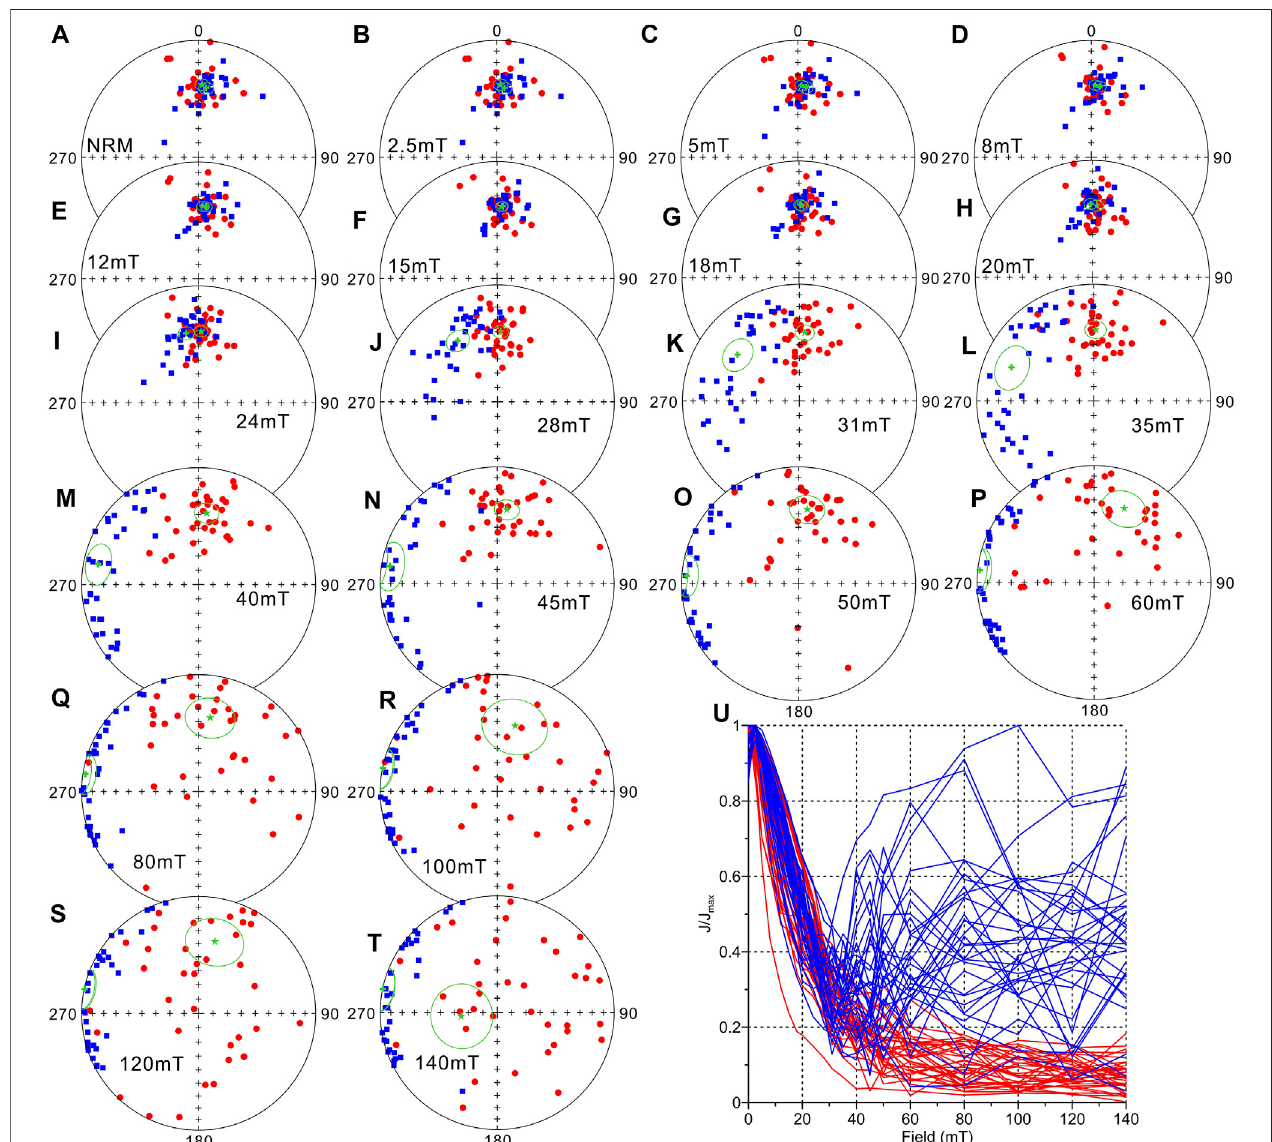
FIGURE8|(A – T) Equal-areaprojectionsoftheAFdemagnetizationdirectionsateach step.Reddots(bluesquares)denotethesamplesofType1and2samples. All diagrams are displayed in geographic coordinates. (U) Normalized remanence decay curves. Red (blue) lines denote the samples of Type 1 (Type 2) granite.